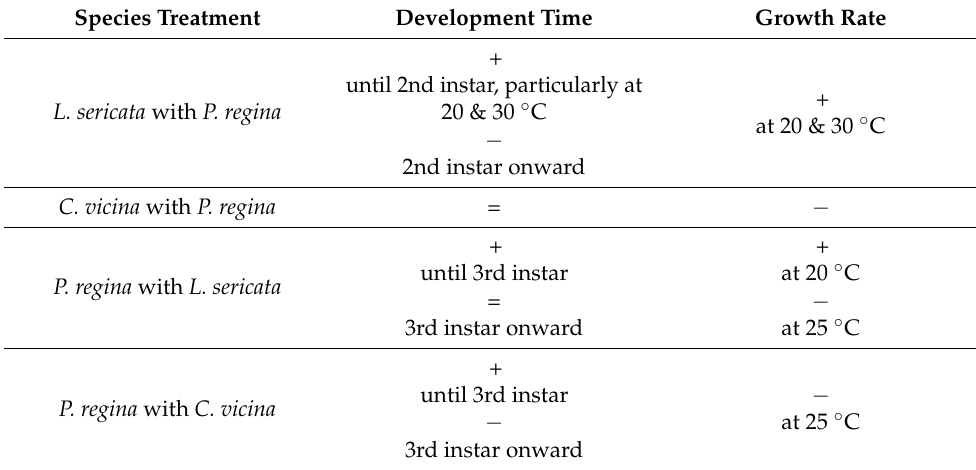
Table 4. Summary of heterospecific species treatment effects on development time and growth rate (larval mass/time) when compared to species reared alone. + indicates a positive effect; − indicates a negative effect; = indicates a neutral